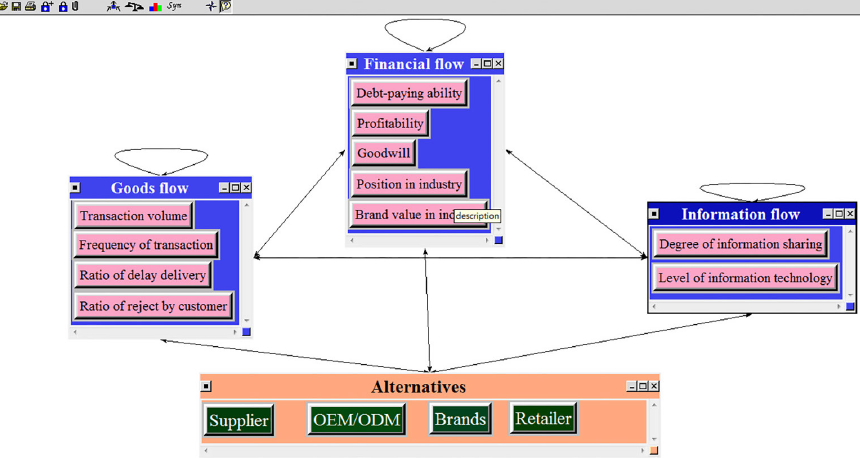
Fig. 6. Network structure to evaluate the optimal CO in smartphone SC for